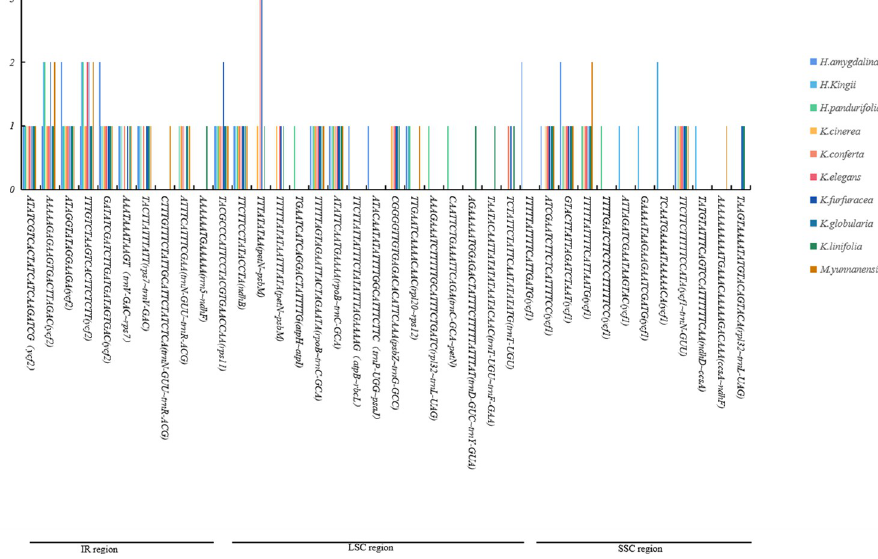
Fig 3. Details of tandem repeats sequence in 10 species and number of repeats in each species. The gene or intergenic regions in parentheses indicates the location of the tandem repeat. The ordinate represents the number of